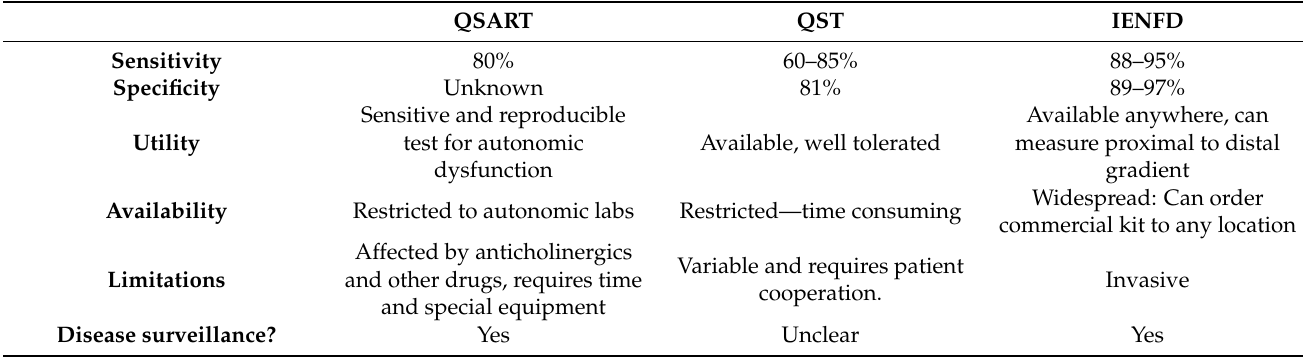
Table 3. Comparison of QSART, QST and IENFD in the evaluation of